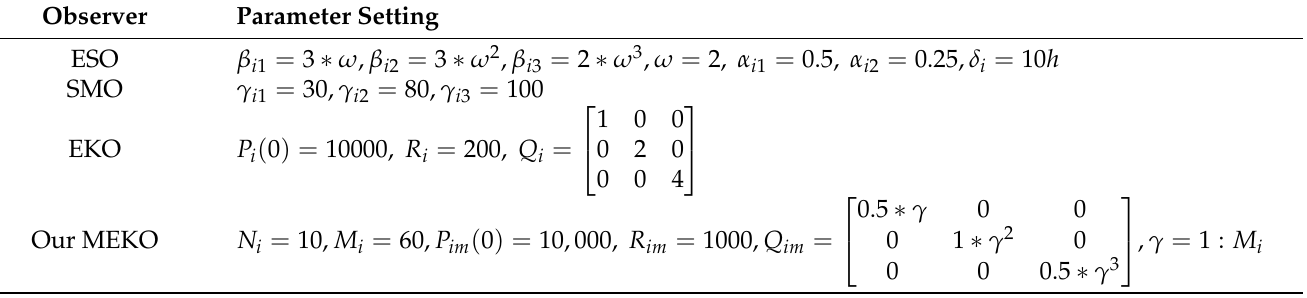
Table 1. Observer parameter